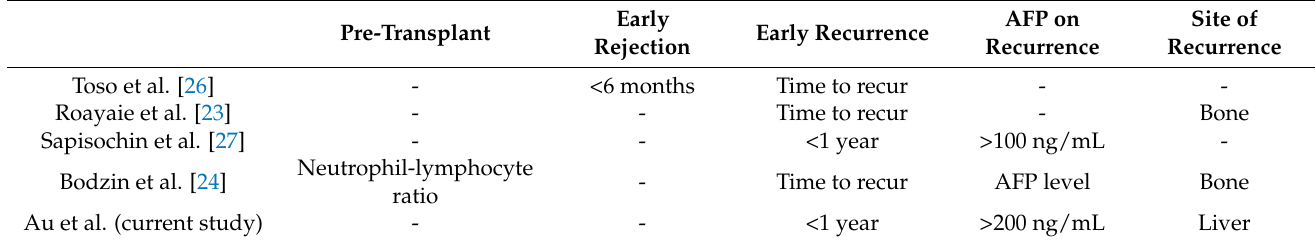
Table 7. Reported biological risk factors affecting post-recurrence